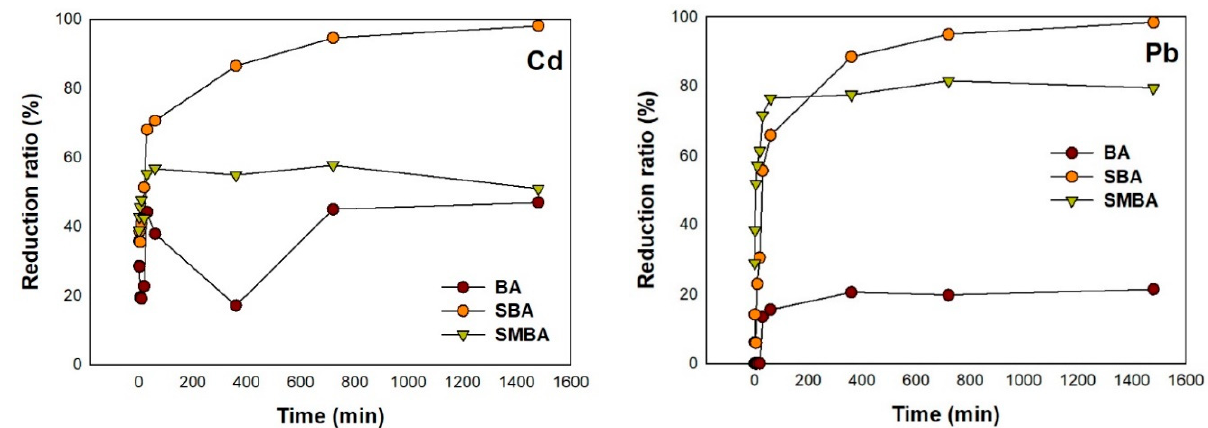
Figure 3. Reduction ratio of Cd and Pb with 3 sorbents at initial concentration of 200 mg/L.